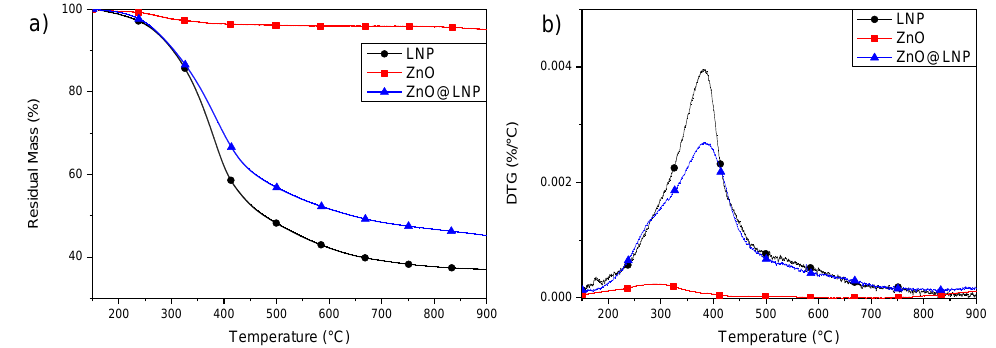
Figure 2. Residual mass ( a ) and Derivative mass loss (DTG) curves ( b ) of LNP, ZnO and ZnO@LNP nanoparticles.